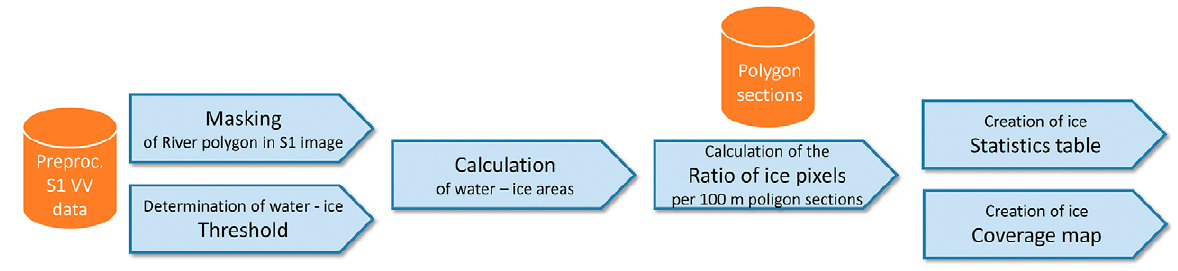
Figure 4. Processing workflow for determining ice cover from preprocessed satellite